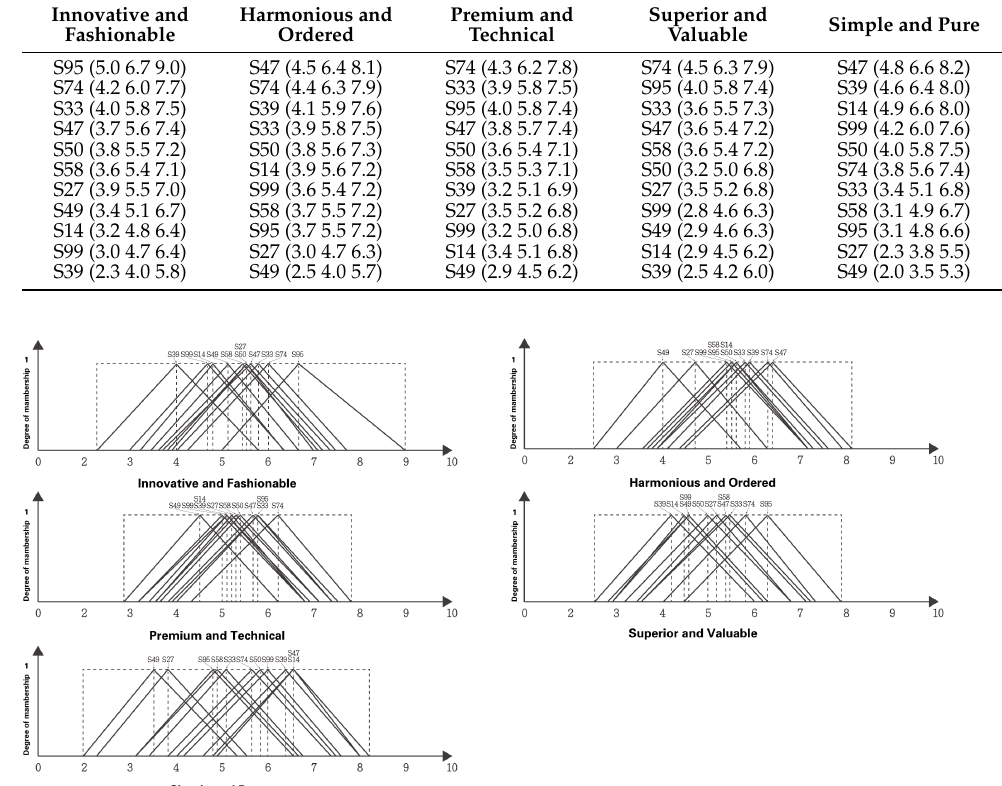
Table 10. The sequence and means of the visual evaluations of the samples of the smartphone rear cameras.